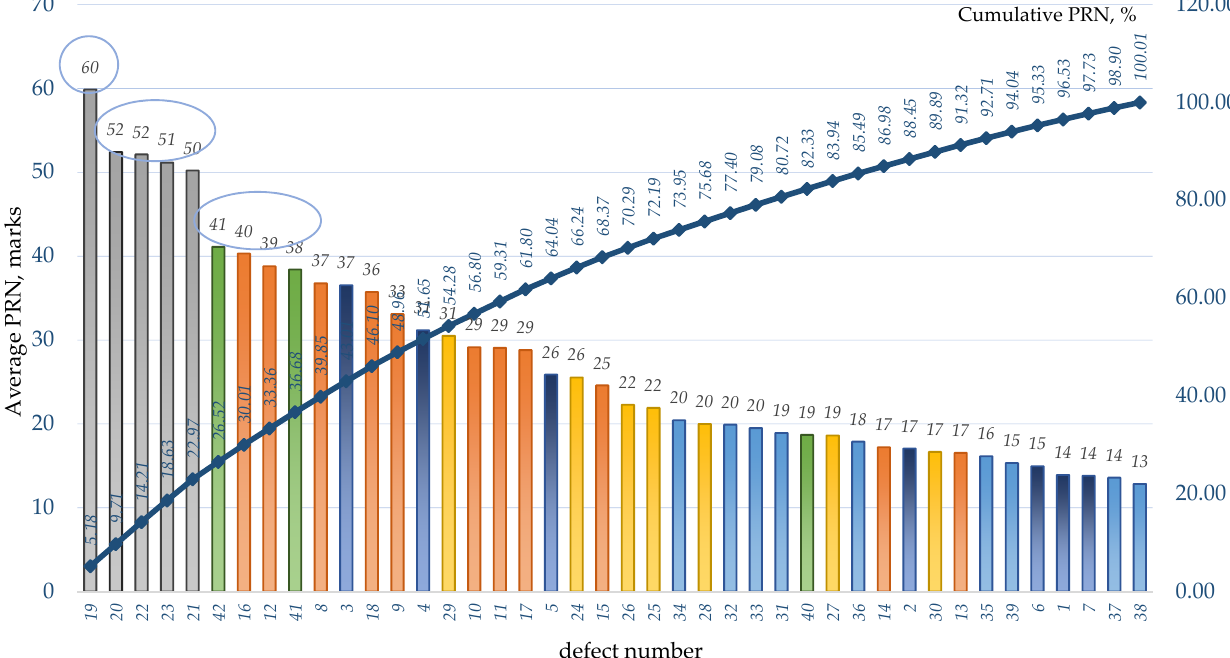
Figure 5. The value of the average score of defects in pharmacies. Notes: 1—Kirovograd region; 2—Khmelnytskyi region; 3—Dnipropetrovsk region; 4—Sumy region; 5—Odesa region; 6–12—Mykolaiv region; 13–15—Kharkiv region; 16–18—Luhansk region; 19–21—Zhytomyr region; 22–28—Rivne region. The criticalness of every deviation impact on the ointments quality was assessed by calculating the PRN value for each pharmacy and found its average value based on the results for all pharmacies. The obtained results were processed by the Pareto method (Fig- ure 6).